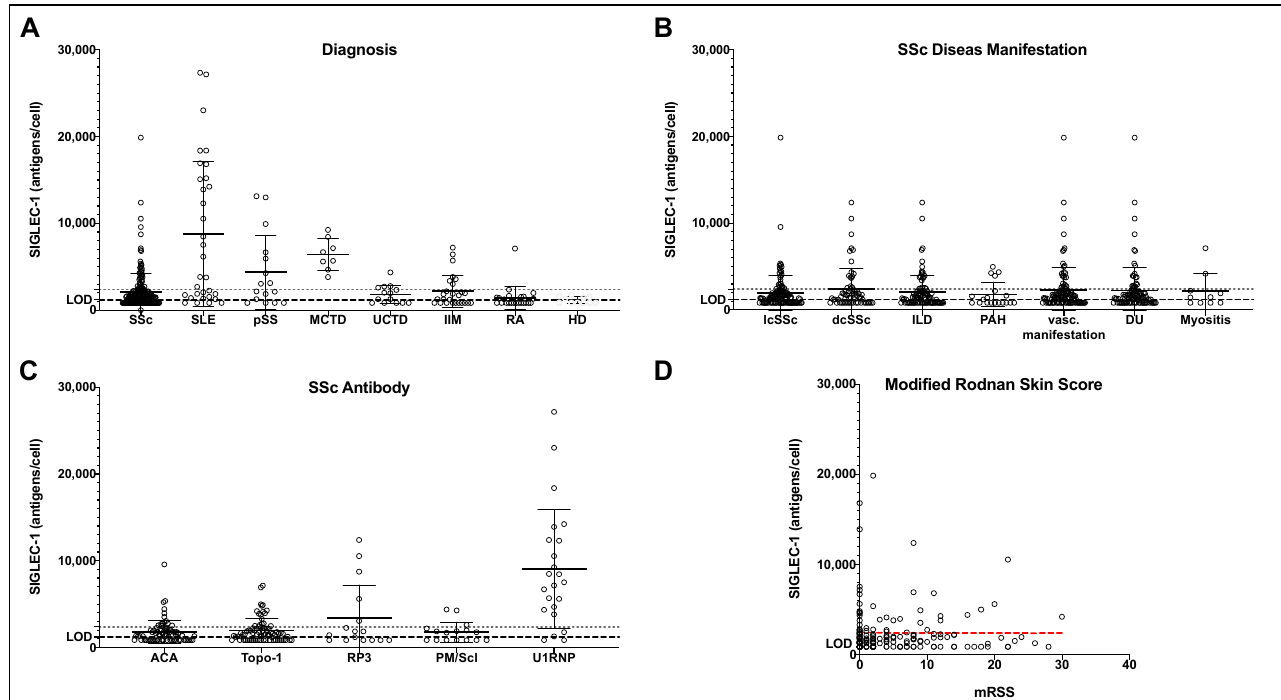
Figure 1. Expression analysis of sialic acid-binding immunoglobulin-like lectin 1 (CD169/SIGLEC-1) on circulating monocytes. ( A ): In patients with SSc, SLE, SS, MCTD, UCTD, IIM, RA, and HDs; ( B ): SSc disease manifestations, including limited (lcSSc) and diffuse (dcSSc) skin involvment, interstitial lung disease (ILD), pulmonary arterial hypertension (PAH), vascular manifestations (referring to PAH, digital ulcera, and scleroderma renal crisis), digital ulcera (DU), and SSc-associated myositis; ( C ): SSc specific antibodies, including anti-centromer antibodies (ACA), anti-topoisomerase-1 antibodies (Topo-1), RNA-polymerase 3 antibodies (RP3), PM/Scl and U1RNP antibodies. ( D ): Correlation of modified Rodnan Skin Score (mRSS) and SIGELC-1. The dashed line indicates the lower detection limit of 1200 molecules/monocyte. Values below the limit of detection (LOD) are shown as LOD/ √ 2. The dotted line indicates the reference range for SIGELC-1 expression. In SSc patients, there was no difference between those who were receiving immuno- suppression and those who were not (2164.94 ± 2385.49 vs. 1962.54 ± 1417.75, p = 0.47). In